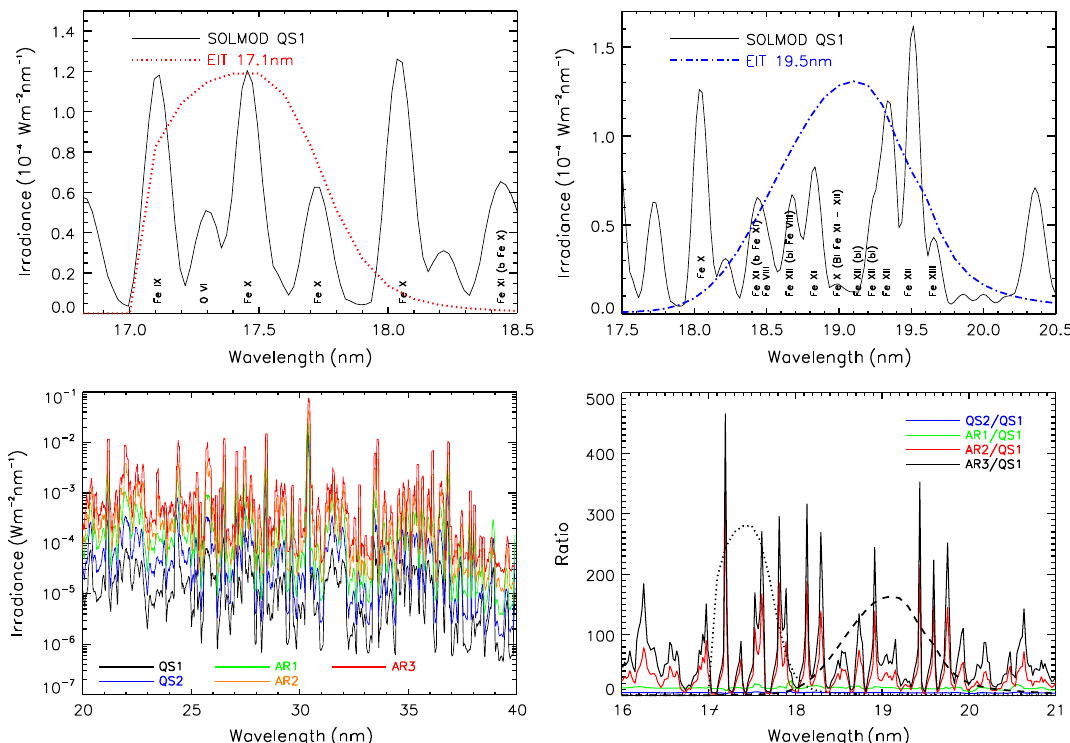
Fig. 1. Top panels: synthetic EUV irradiance spectrum (black line) convolved with a 1-Å boxcar calculated for the feature QS1, along with the passbands of the EIT 171 Å (left panel, red dotted line) and 195 Å (right panel, blue dashed line) channels (in arbitrary scale). Bottom panels: the left panel shows the irradiance spectra for QS1 (black), QS2 (blue), AR1 (green), AR2 (orange), and AR3 (red). The right panel gives the ratios of the synthetic spectra for each component to the QS1 spectrum. The EIT 171 Å and 195 Å passbands are indicated again.